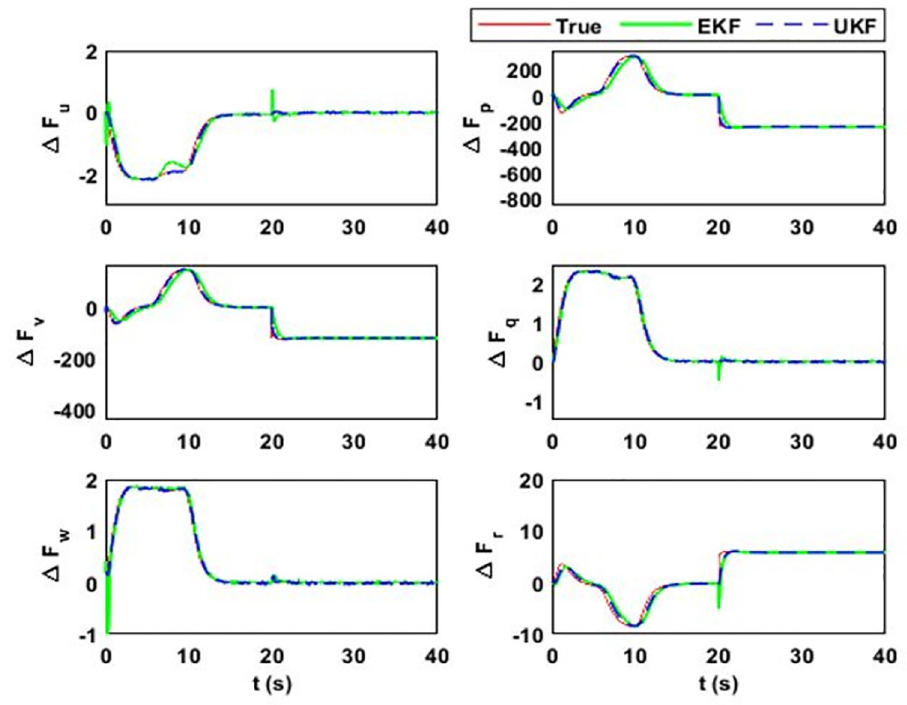
Fig 9. Estimation of model uncertainty and disturbance vector. In this case, the total effect on airship body axes linear and angular acceleration is estimated due to the aerodynamic model and wind disturbance corresponding to (i) Δ F u ; (ii) Δ F p ; (iii) Δ F v ; (iv) Δ F q ; (v) Δ F w ; (vi) Δ F r